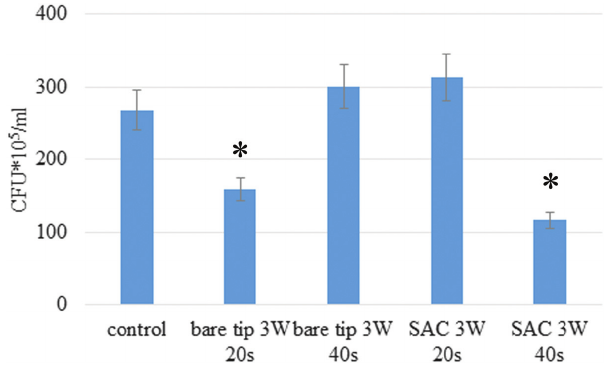
Fig. 1. The number of CFUs in E. coli suspension irradiated at 3 W for 20 s and 40 s. *Data show signi¯cant di®erence compared with the control, p (cid:5) 0 :